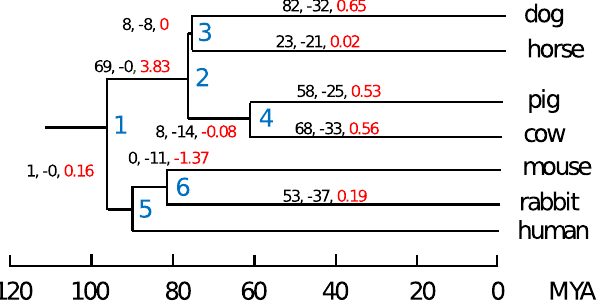
Figure 2. Gain and loss of miRNA clusters across the phylogenetic tree, as inferred by Dollo parsimony and synteny analyses. For each branch of the tree, the (black labelled) number of gained ( + ) and lost ( − ) orthogroups is provided. Red labelled numbers represent the branch specific net gain rate of orthogroups per million year.